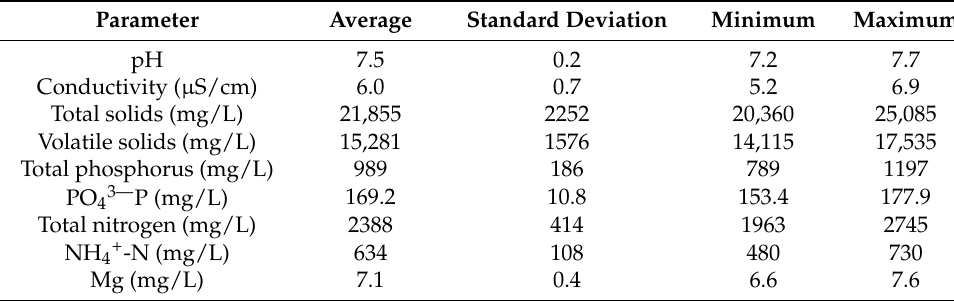
Table 1. Characteristics of the anaerobic sludge samples ( n =